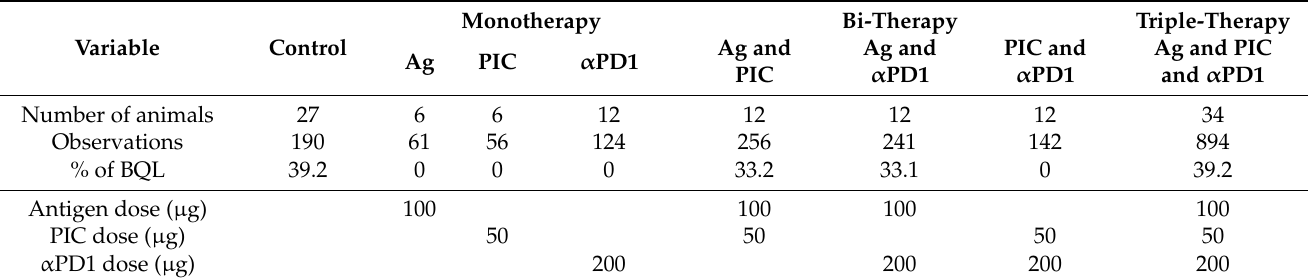
Table 1. Summary of study design characteristics.